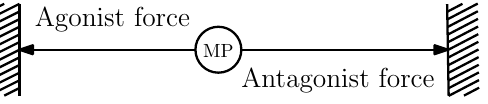
Figure 1. Agonist–antagonist mechanical scheme.